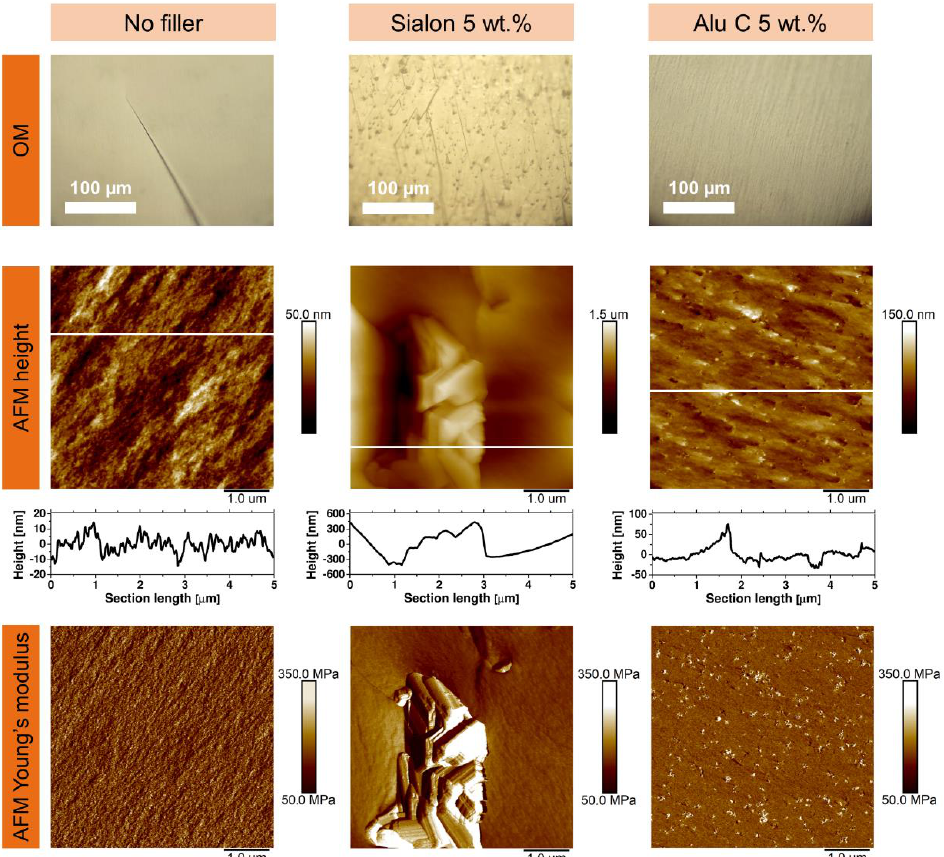
Figure 9. Cumulative OM and AFM images of the bulk surfaces (fractured specimens): unfilled, filled with Sialon 5 wt.% and filled with Alu C 5 wt.% particles. White lines in the height images are profiles of the cross-section analysis shown under them.